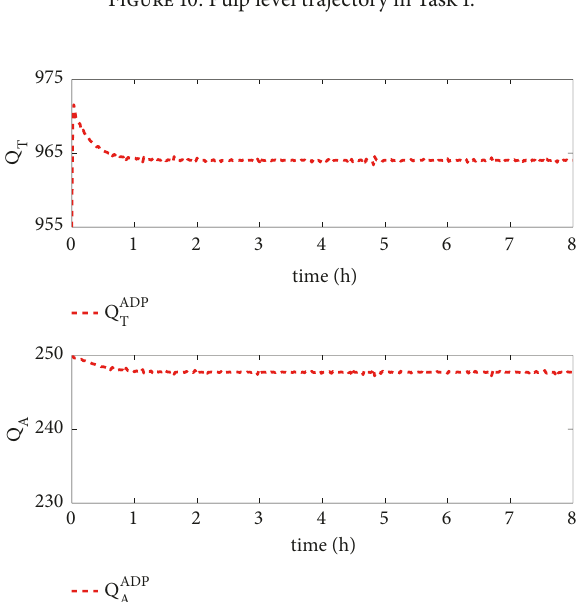
Figure 10: Pulp level trajectory in Task 1.